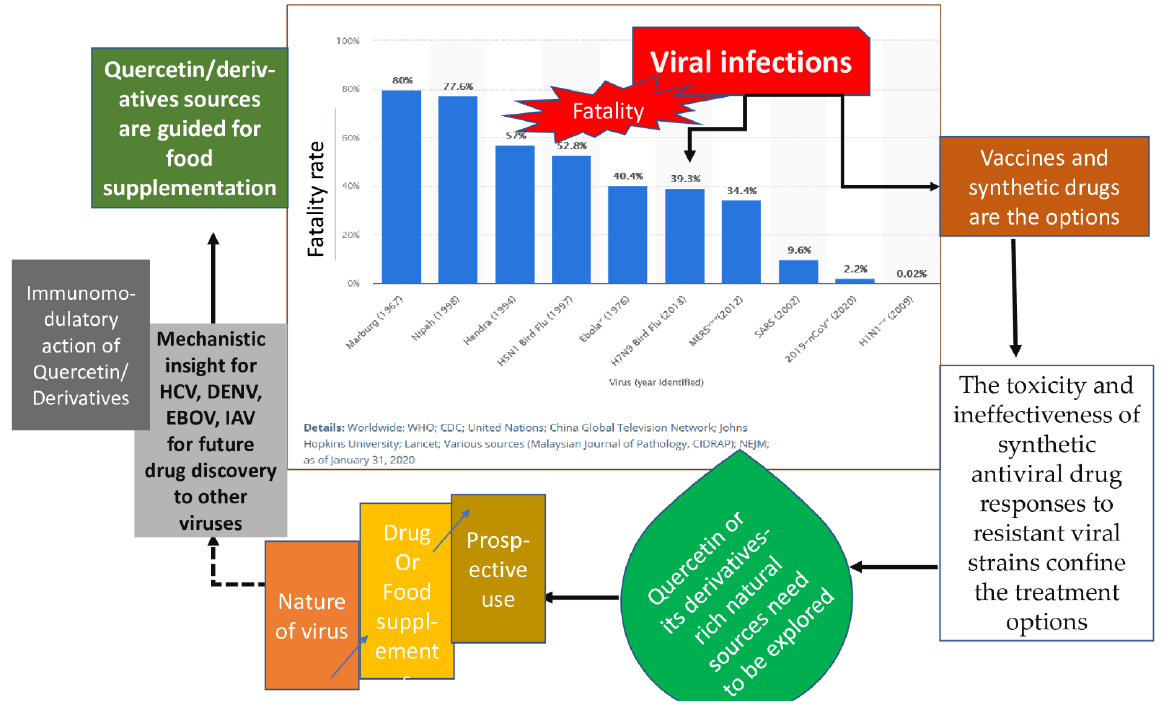
Figure 2. Schematic design aiming the approach and objective of this review.